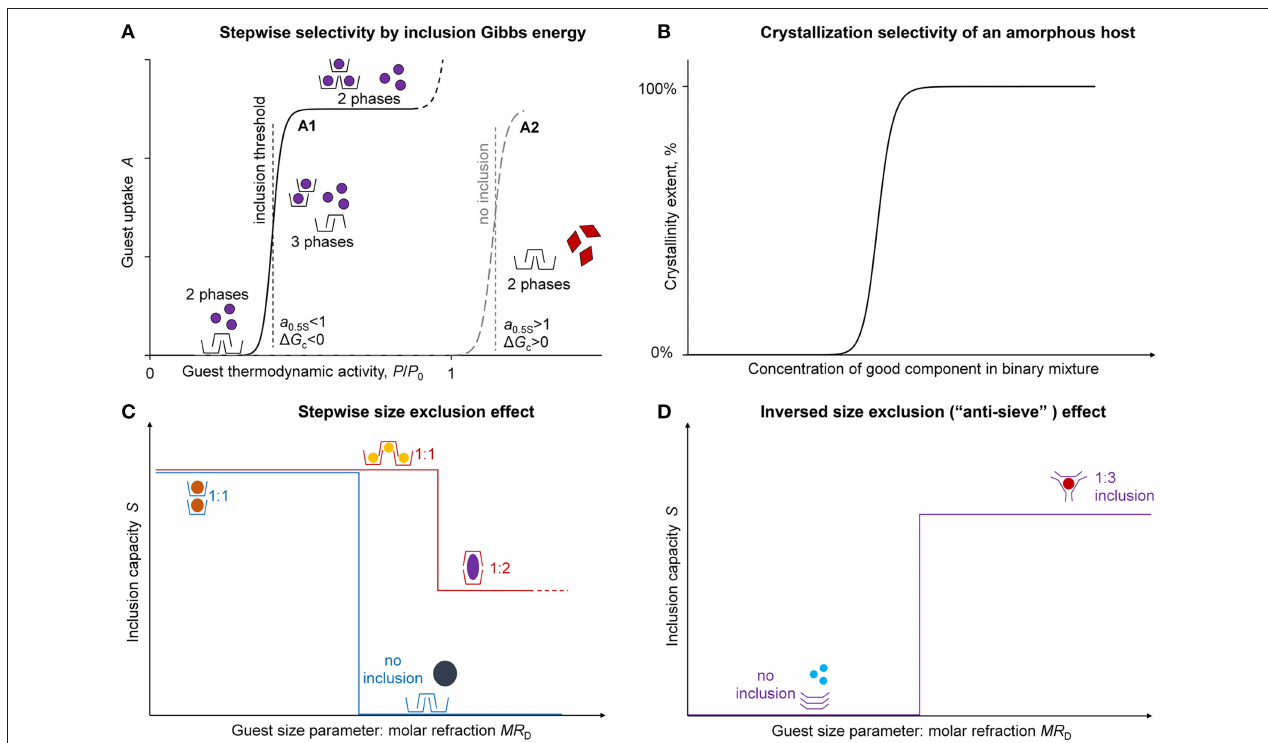
FIGURE 1 | Stepwise inclusion selectivity of solid hosts. (A) Stepwise selectivity by inclusion Gibbs energy; (B) crystallization selectivity of an amorphous host; (C) stepwise size exclusion effect; (D) inversed size exclusion effect